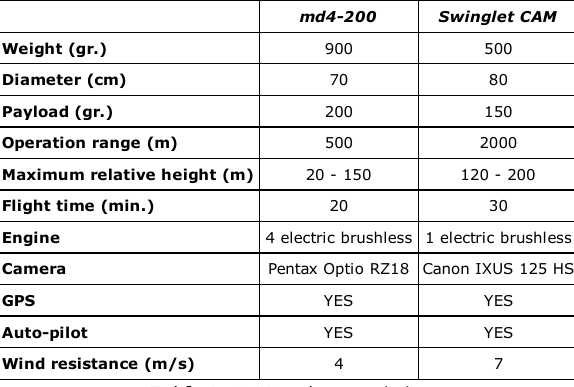
Table 1. UAVs characteristics